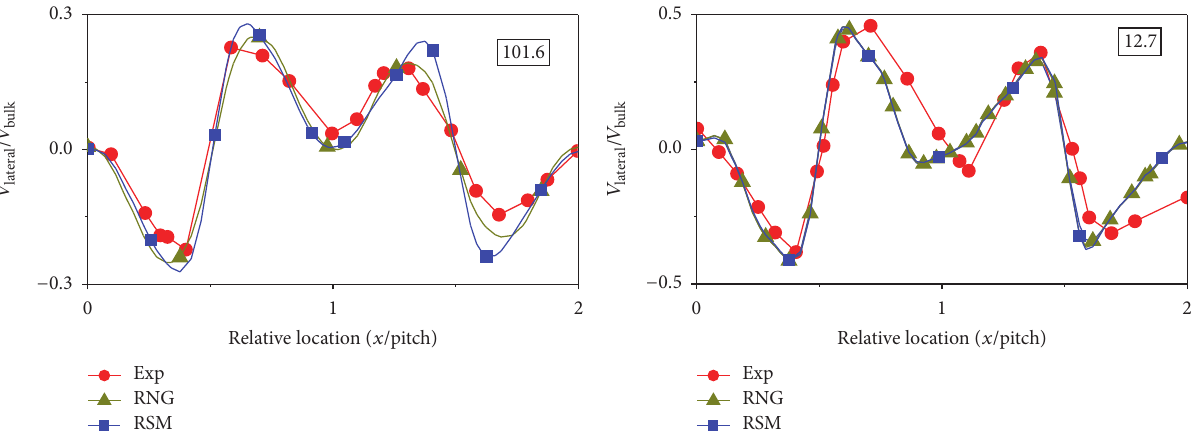
Figure 15: Validation for lateral flow status.